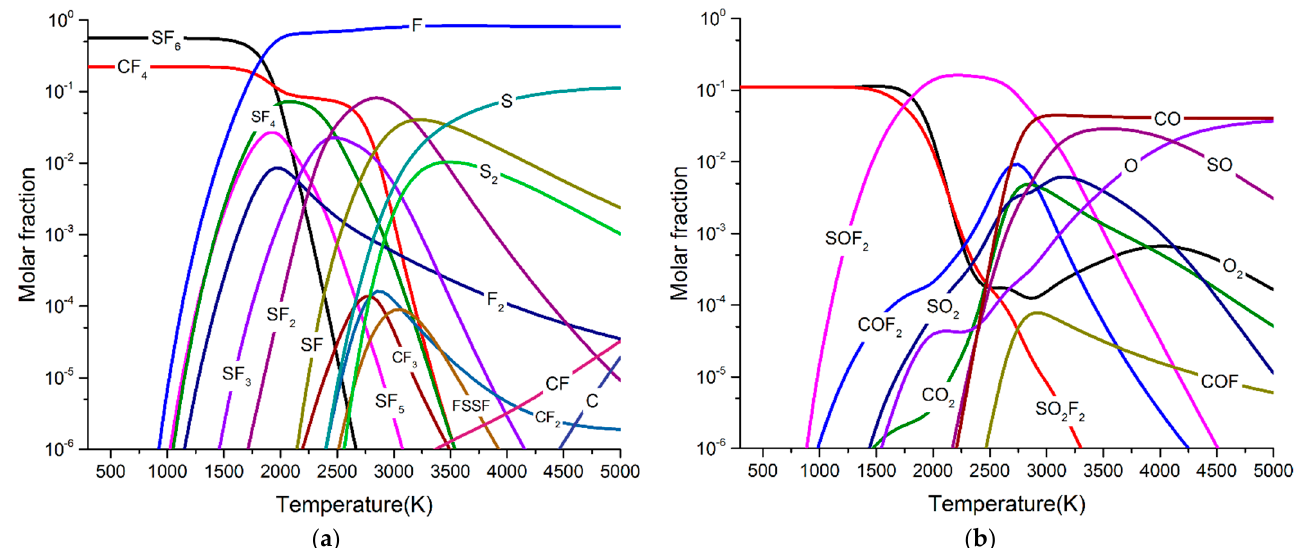
Figure 7. Particle composition of 60% SF 6 + 20% CF 2 + 20% O 2 arc plasma at 0.6 MPa. ( a ) SF 6 , SF 5 , SF 4 , SF 3 , SF 2 , SF, S, S 2 , F, F 2 , FSSF, CF 4 , CF 3 , CF 2 , CF, and C particles. ( b ) SOF 2 , SO 2 F 2 , COF 2 , COF, O 2 , O, SO 2 , SO, CO 2 , and CO particles.